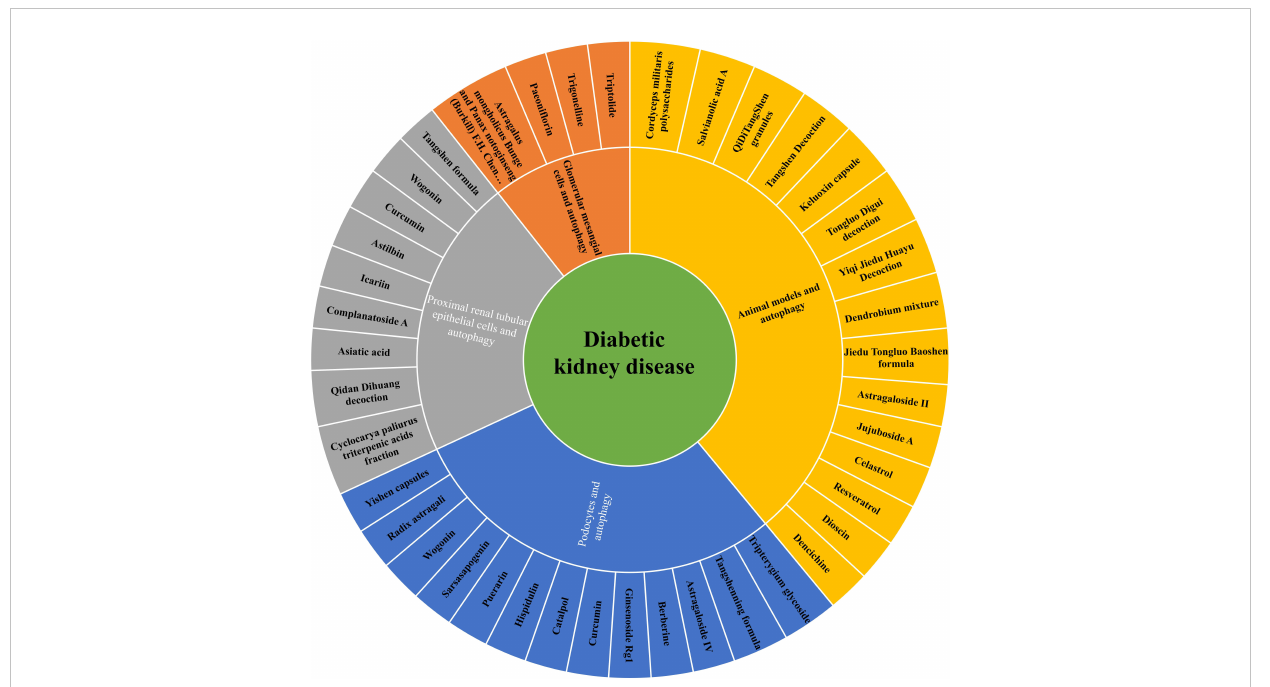
FIGURE 3 The role of Chinese herbal compound preparations, single herbs and active compounds against renal injuries via regulating autophagy in